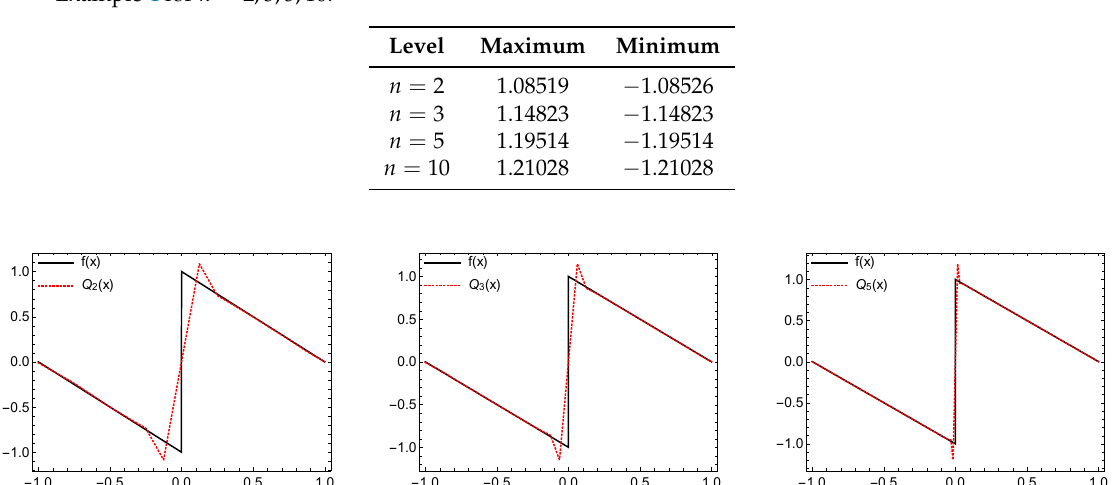
Table 4. Approximate maximum overshoot and undershoot in neighborhoods of x = 0 using Q n f of Example 4 for n = 2,3,5,10.